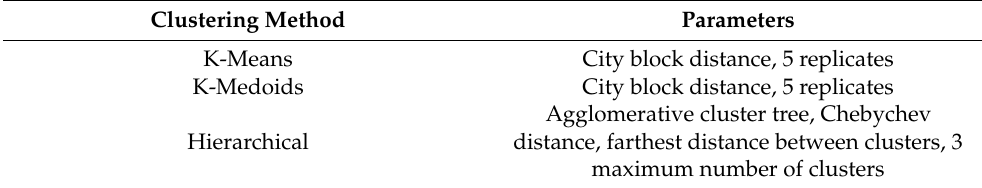
Table 2. Parameter settings for clustering